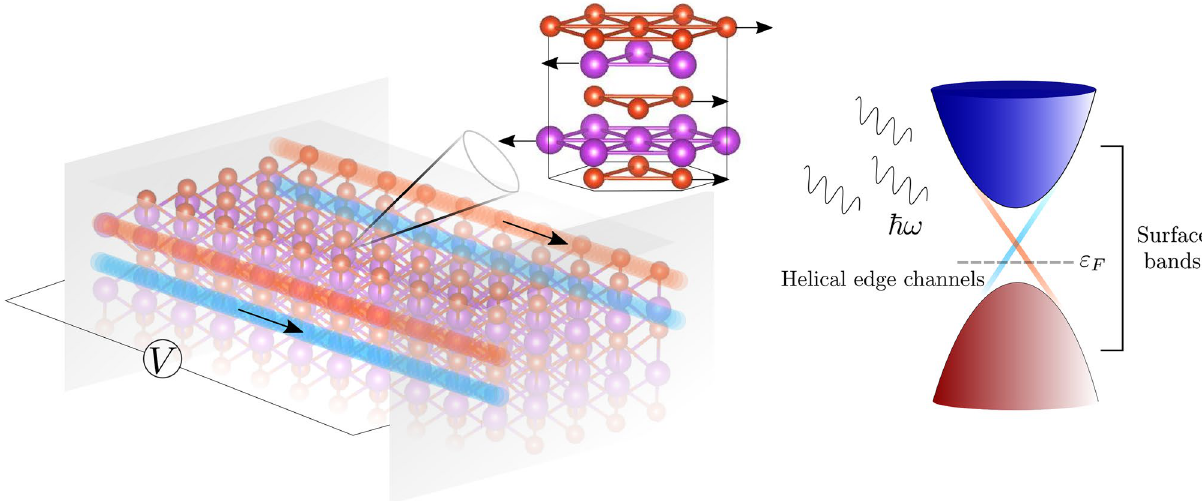
Figure 1. Lattice oscillations in the topological electronic transport. Schematic illustration of helical edge states and surface of a 3DTI in thin-film conditions. The energy spectrum is displayed on the right side of the